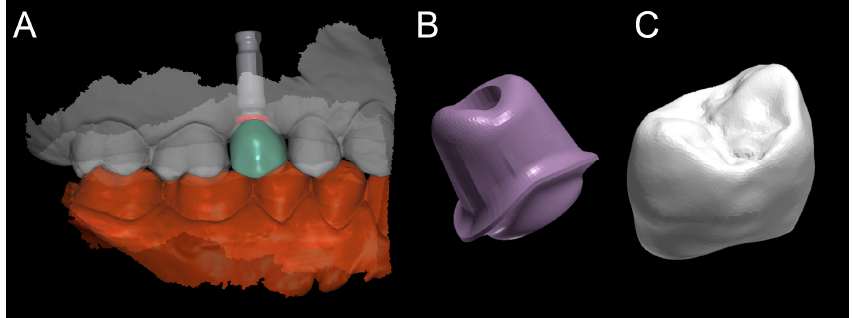
Figure 12. Computer assisted design project (EXOCAD ® , Darmstadt, Germany). ( A ) CAD scene. ( B ) Details of the individual zirconia abutment (upper portion of the hybrid abutment); and ( C ) PMMA crown.